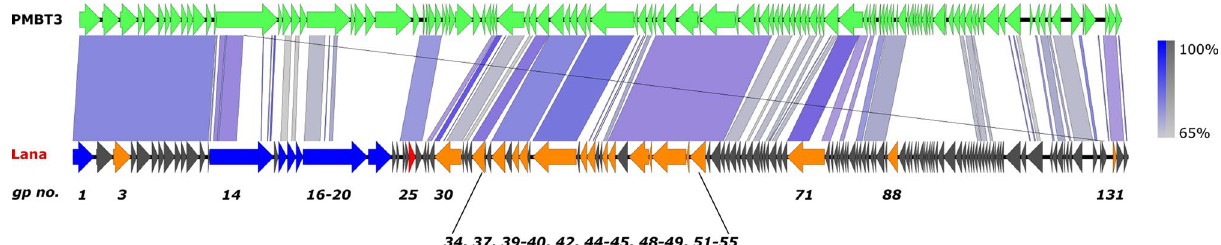
Figure 4. Genome comparison of Lana (bottom) and PMBT3 using the Easyfig genome visualisation tool in BLASTn mode (version 2.2.3). Nucleotide similarity at different regions between genomes is given in percentages (right